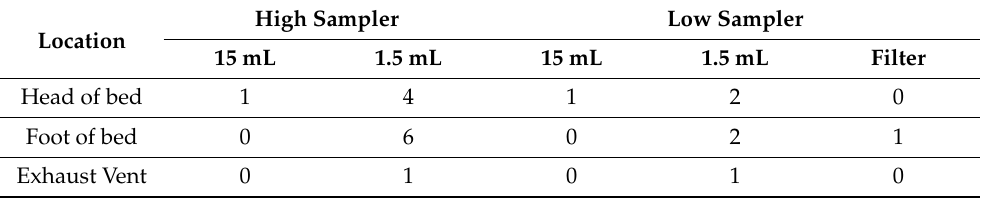
Table 2. Number of positive aerosol samples from each sampler location and collection